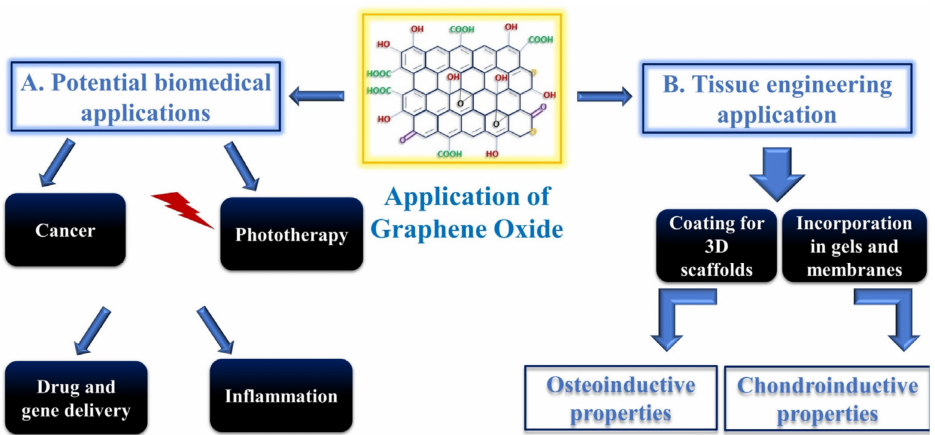
Figure 2. Biomedical applications of GO. ( A ) Among others, GO is used in phototherapy, cancer treatments, drug and gene delivery, and inflammation treatment. ( B ) Application of GO in tissue engineering and stem cell differentiation as osteoconductive and chondroinductive material